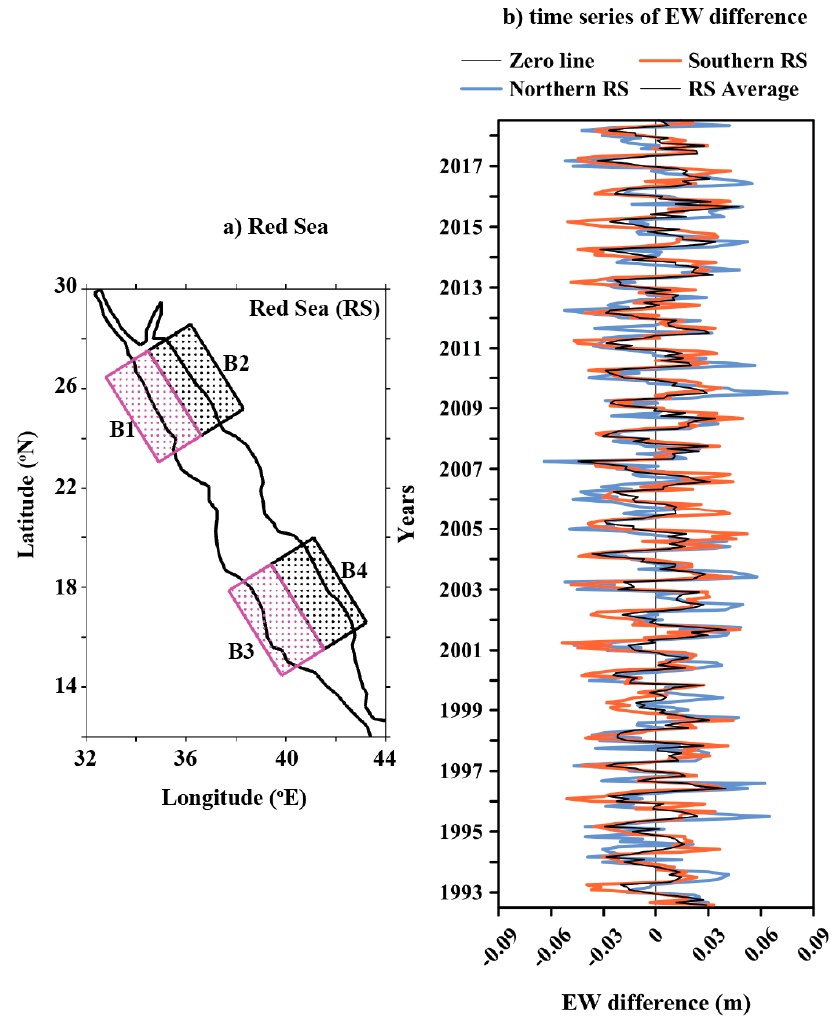
Figure 5. ( a ) The rectangular boxes considered from the northern and southern Red Sea in an inclined plane (inclined to the left by 32 degrees from true north). The boxes are named B1 (northwestern), B2 (northeastern), B3 (southwestern), and B4 (southeastern). ( b ) The time series of the EW sea level difference for the northern (B2-B1) and southern (B4-B3)